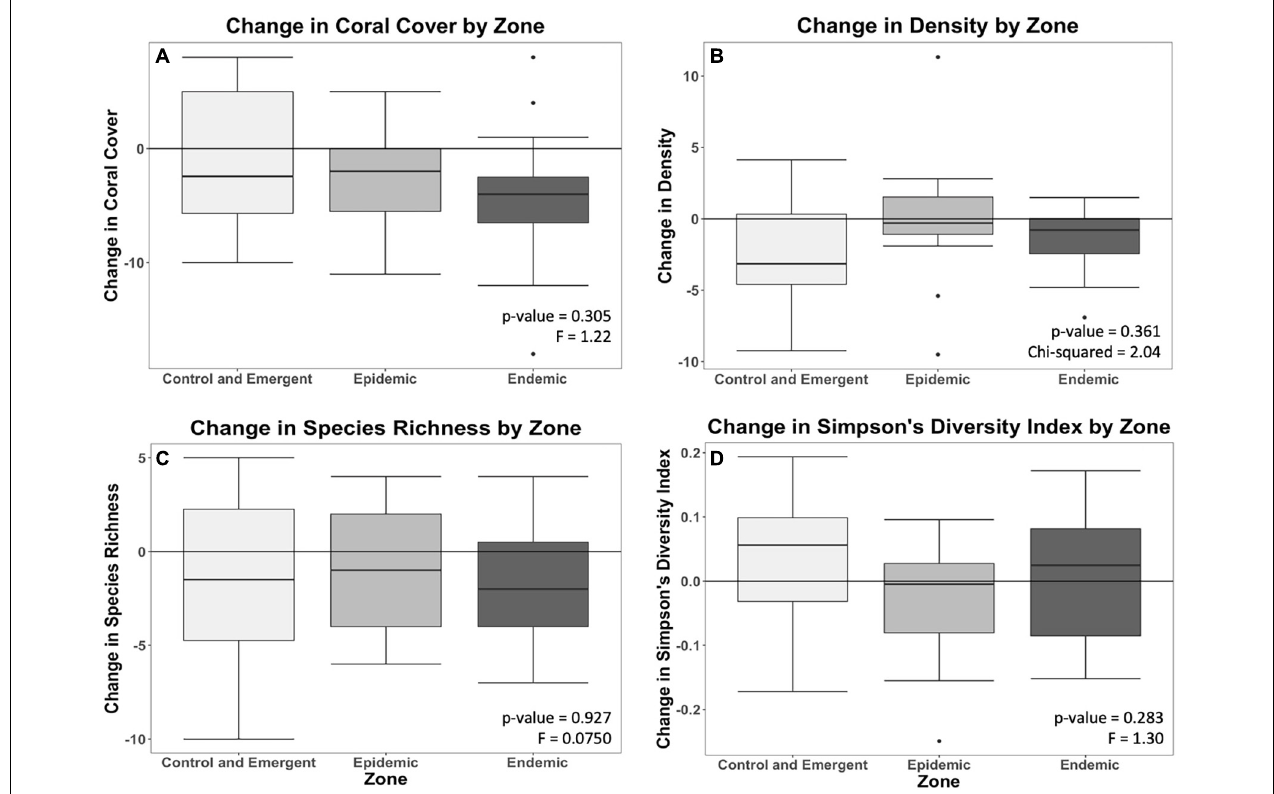
FIGURE 3 | Change (from pre-outbreak to 2020) in coral cover (A) , density (B) , richness (C) , and Simpson’s Diversity Index (D) in each zone.